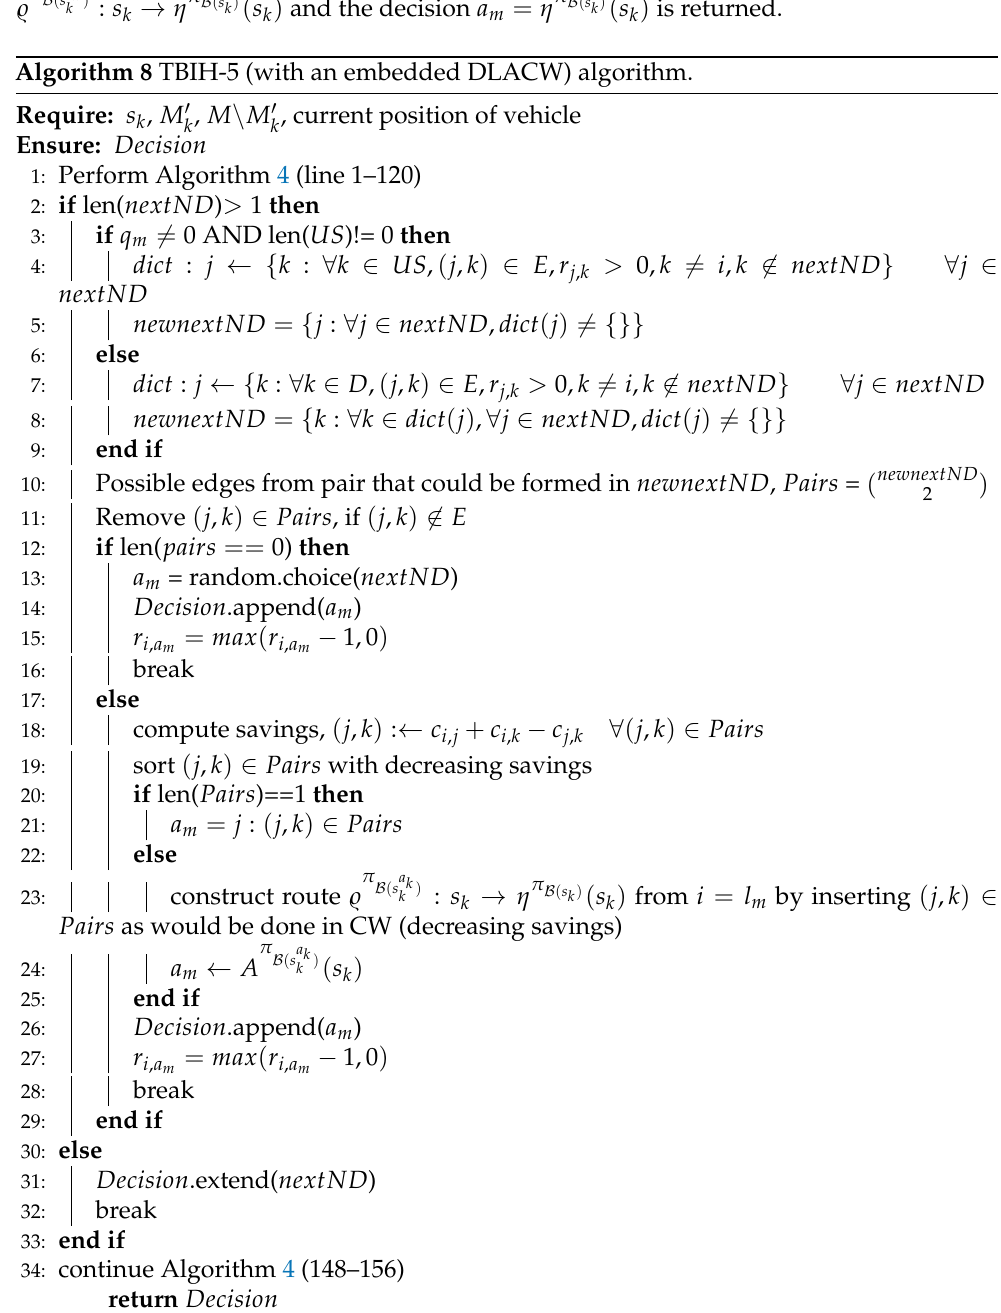
Algorithm 8 TBIH-5 (with an embedded DLACW)